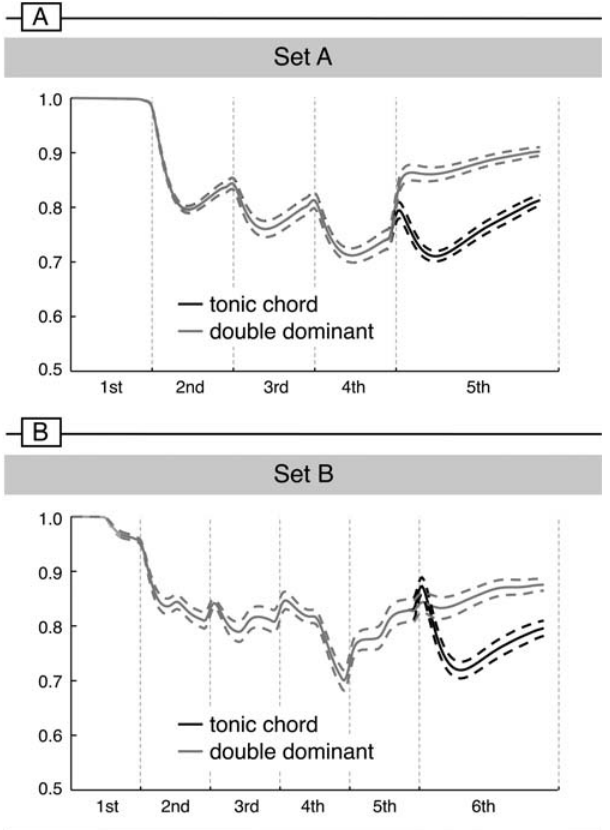
Figure 2. Correlation of local context (pitch image of the current chord) with global context (echoic memory represen- tation as established by previously heard chords), separately for Set A (homophonic sequences, top) and B (polyphonic sequences, bottom). The data show that music-syntactically irregular chord sequence endings (DDs: grey line) were even more congruent with the preceding harmonic context than music-syntactically regular endings (final tonics: black line). For each sequence type, correlations were calculated for all twelve major keys (the line for each sequence type represents the mean correlation, the dashed lines indicate standard error of mean). Auditory modelling was performed using the Contextuality Module of the IPEM-Toolbox (Leman et al., 2005), length of local context integration window was 0.1 sec, global context integration window was 1.5 sec (as suggested by Leman, 2000). The abscissa represents the time line (each chords had a duration of 500 ms, except the last chord which was presented for 1000 ms), the ordinate depicts correlation values. Note that the dip at the beginning of the final tonic in the bottom panel does not represent a statistically significant difference between final tonics and final DDs (t(11)=0.378, p . .7, t-test for paired samples comparing the mean pitch commonality values of DDs vs. final tonics within a time window from 0 to 240 ms after the onset of the final